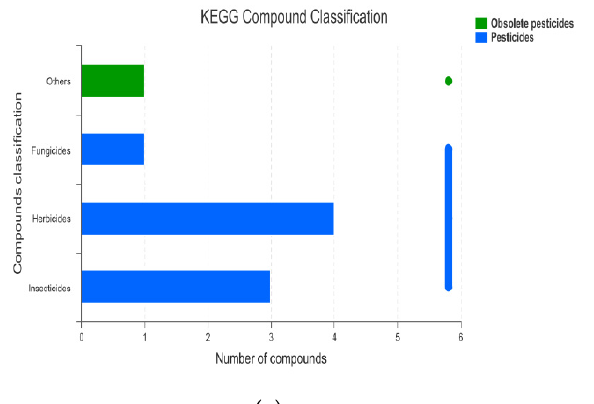
Figure 2. Classification of metabolites based on Kyoto Encyclopedia of Genes and Genomes (KEGG) annotation: ( a ) compounds with biological roles; ( b ) phytochemical compounds; ( c ) lipids; ( d ) pesticides; ( e ) endocrine disrupting compounds.